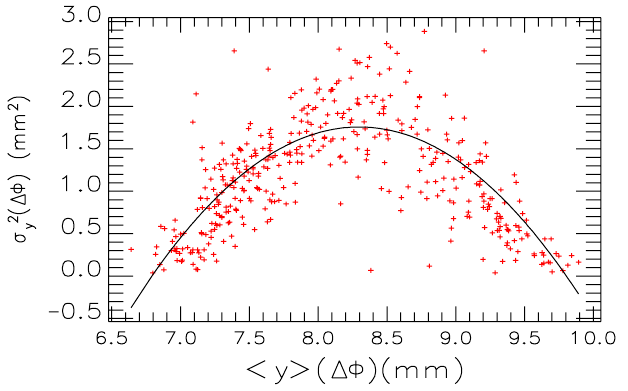
FIG. 4. (Color) The fit between (cid:7) 2 crosses are obtained from five images of the same turn, the black curve is a hypobola fit. The fit result is (cid:7) 2 predicted coefficient is (cid:2) 0 : 113 .